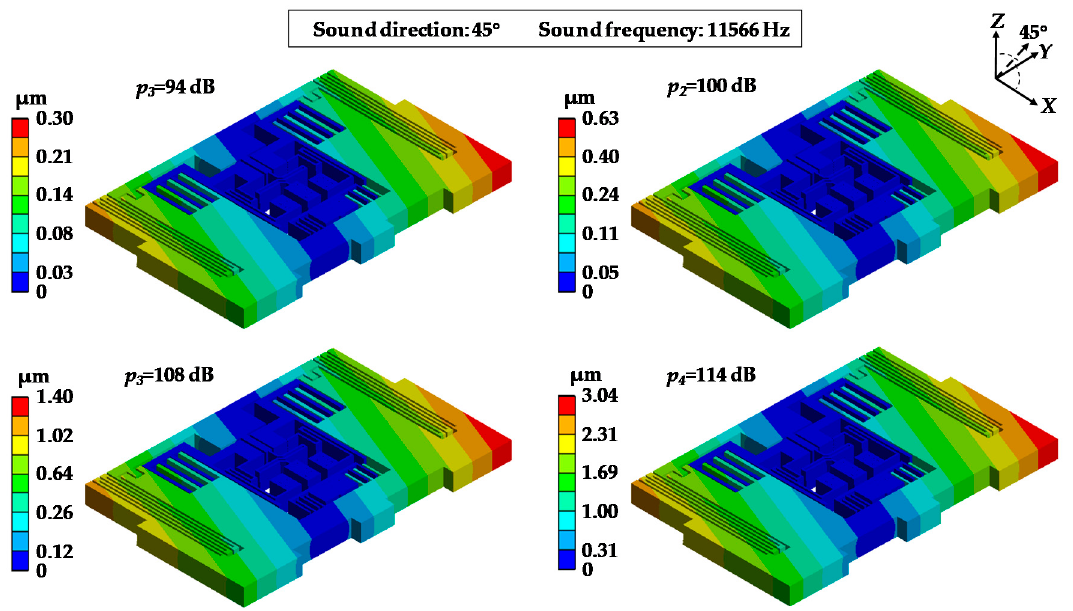
Figure 11. Deformation distributions of MPU6050-Y under acoustic injection of different sound pressures.